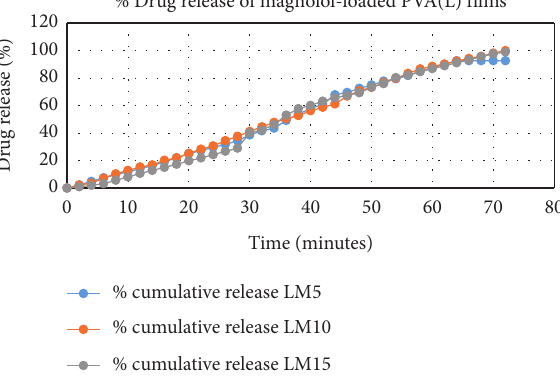
Figure 15: Drug release of magnolol-loaded PVA (L)